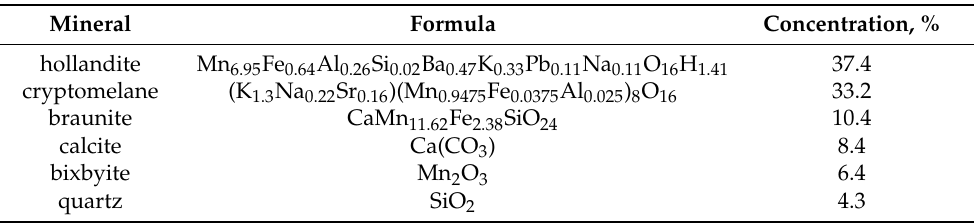
Table 6. Results of semantical XRD analysis of crystalline phases of manganese ore sample from the Bogach deposit.